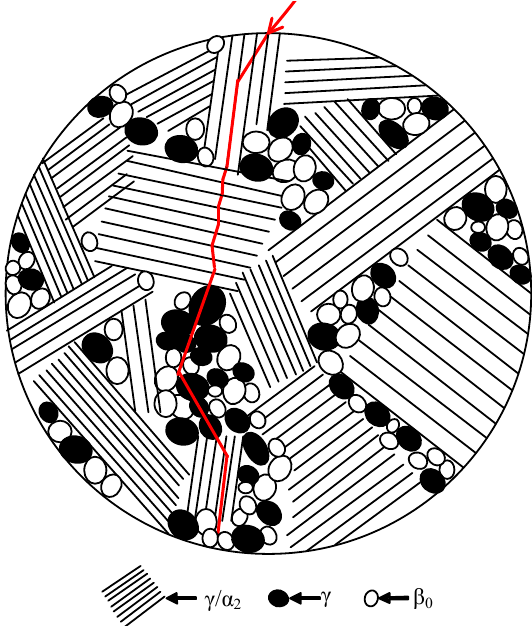
Figure 9. The crack propagation model in the coarse lamellar microstructure.